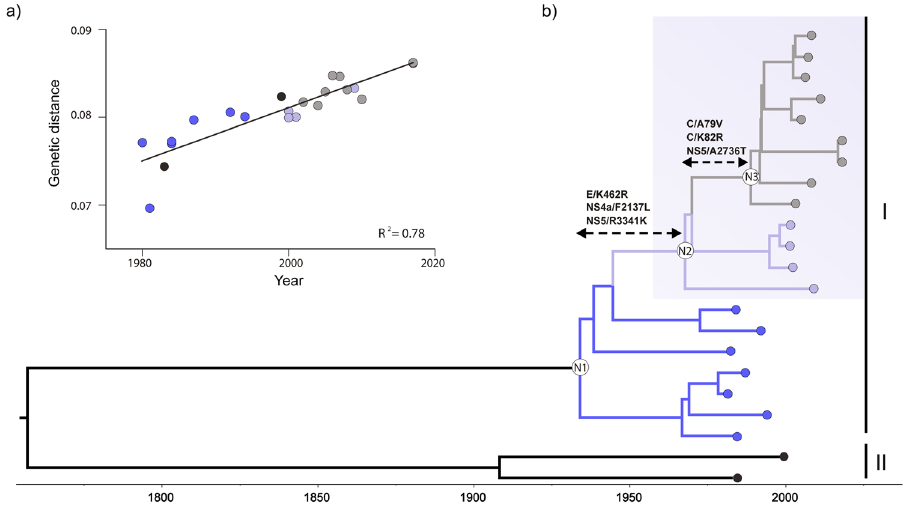
Figure 4. Evolutionary analysis of YFV genotype I and II complete coding sequences (CDS). ( a ) Correlation between the sampling date of each sequence and the genetic distance of that sequence from the root of a maximum likelihood phylogeny of the YFV CDS (R 2 = 0.78) is displayed (top left). ( b ) Time-scaled Bayesian MCC tree of YFV CDS. The shaded box highlights the modern-lineage clade. Genotype I branches corresponding to old, modern-basal and modern-subclade 1E lineages were colored in blue, light purple and gray, respectively. Reconstructed ancestral key nodes of all genotype I sequences (N1), all modern-lineage sequences (N2) and the modern subclade 1E (N3) are indicated. Inferred amino acid substitutions between ancestral key nodes are shown in relation to the polyprotein